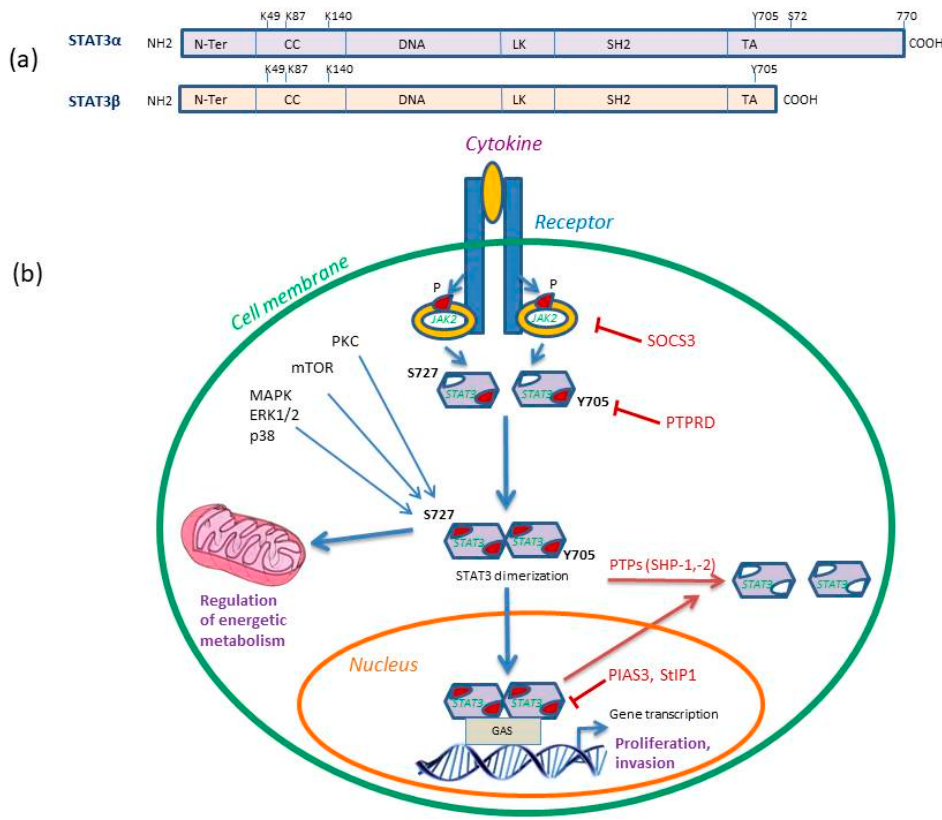
Figure 1. ( a ) STAT3 isoforms structural domains. Both isoforms consist of the N-terminal domain (N-Ter), a coiled coil (CC), a DNA binding domain (DNA), a linker domain (LK), the Src homology 2 (SH2) and the C-terminal transactivation domain (TA) that contains the two phosphorylation sites Tyr-705 (Y705) and Ser-727 (S727) involved in gene transcription activity. The STAT3 K49 and K87 residues are targets of acetylation and K140 of methylation. ( b ) STAT3 signaling pathway in cancer. STAT3-Y705 phosphorylation is induced by JAK2 recruitment and phosphorylation. STAT3-S727 phosphorylation is mediated by PKC, MAPK or mTOR pathway and it can further regulate cell bioenergetics. Activated STAT3 homodimerizes and translocates to the nucleus where it binds gamma-activated sequences (GAS) to initiate gene transcription and regulation. The inhibitors of STAT3 signaling are shown, including suppressor of cytokine signaling 3 (SOCS3) that inhibits JAK2, receptor-type tyrosine-protein phosphatase delta (PTPRD) that dephosphorylates Y705 site and protein inhibitor of activated STAT3 (PIAS3) and STAT3 interacting protein (StIP1), which directly inhibit activated STAT3. The SH2-containing SHP-1 and SHP-2 protein tyrosine phosphatases (PTPs) dephosphorylate pSTAT3-Y705 dimers and render them inactive. P represents phosphorylation. Reproduced/adopted in modified form from [19]. Copyright (Elsevier, 2017).